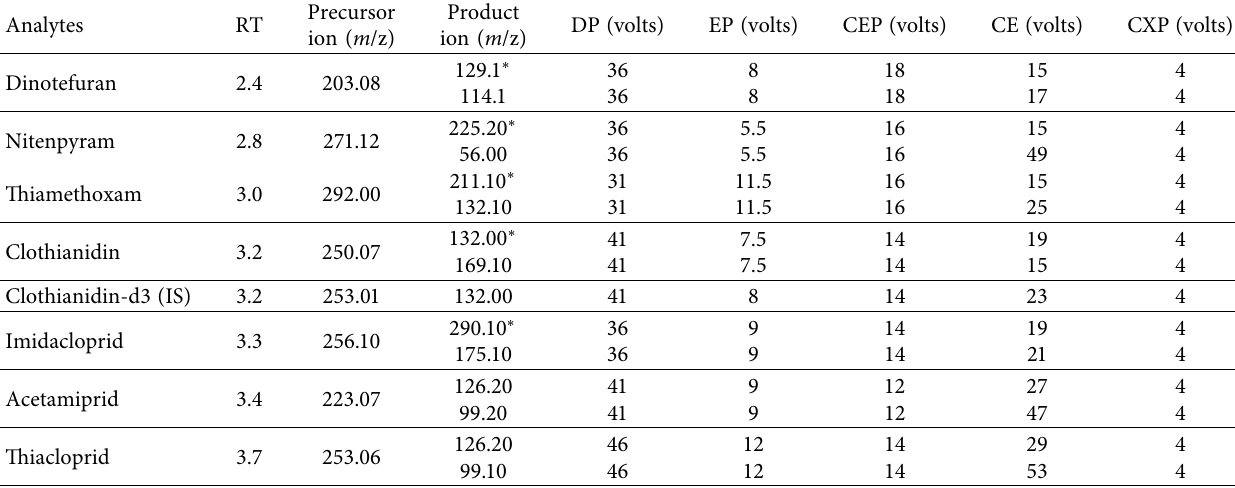
Table 2: MS/MS detector parameters and retention times